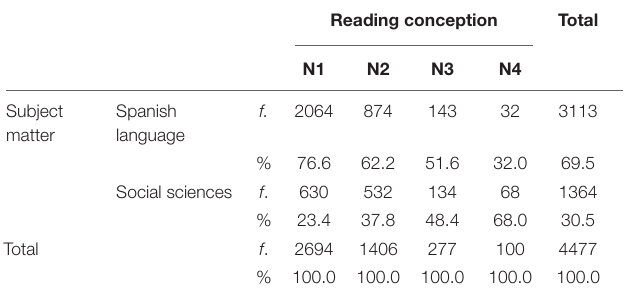
TABLE 5 | Levels of cognitive-reading progress (N3 – literacy criticism).